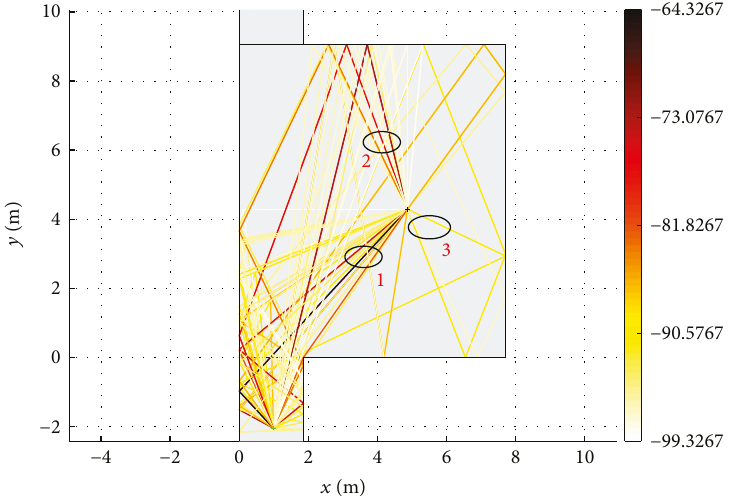
Figure 12: Ray trajectories of the multipath components for Tx position 6 in the